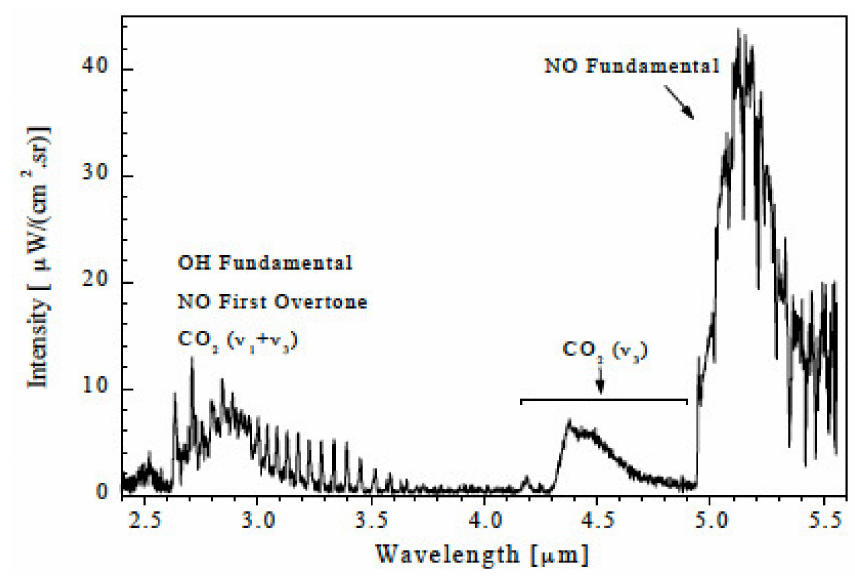
Figure 5. Measured IR spectrum at 1 atm and 3400 K (from